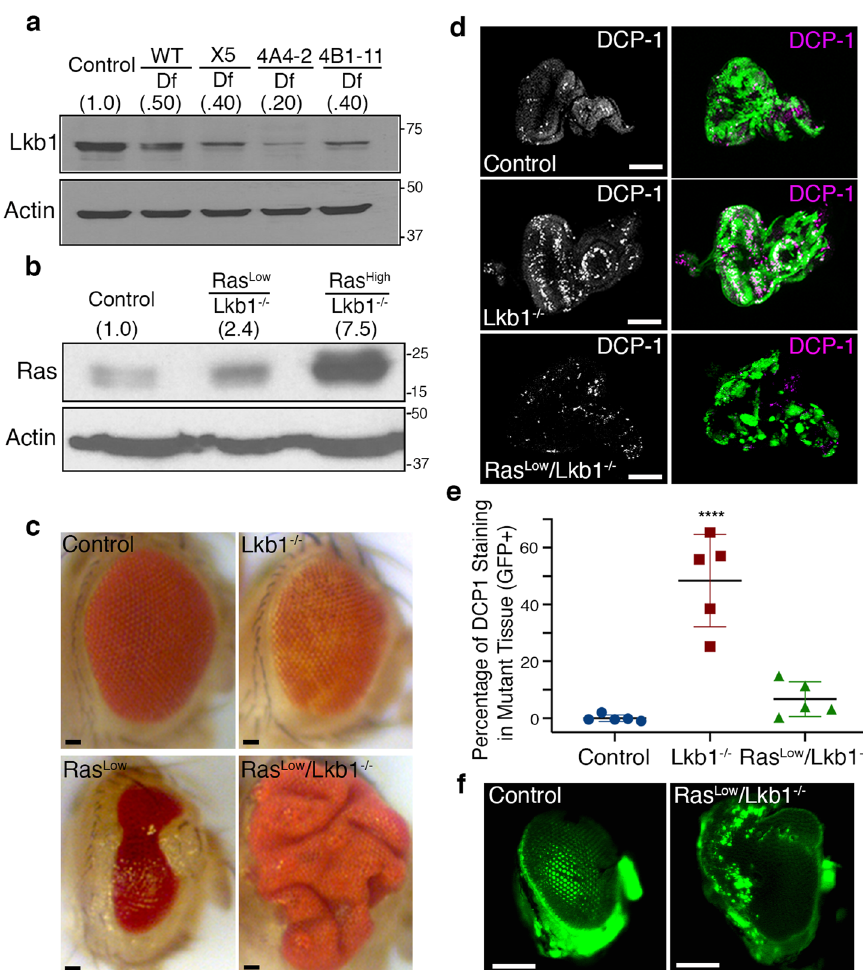
Fig. 1 Clonal loss of Lkb1 in vivo results in autonomous cell death. a Western analysis of Lkb1 protein in larvae transheterozygous for a deletion ( Df(3R) Exel6169 ) that removes the Lkb1 gene, and either a wild-type third chromosome or three loss-of-function alleles of Lkb1 (X5, 4A4-2, 4B1-11). b Western analysis of Ras levels in mosaic eye-imaginal disks from the indicated genotypes (control = FRT82B ). Note the Ras antibody detects both endogenous and oncogenic Ras. c Representative bright fi eld images of mosaic adult eyes with clones of the indicated genotypes. Scale bar, 20 µ m. d Confocal maximum intensity projections of third instar mosaic eye discs carrying GFP-tagged clones of the indicated genotypes, and stained for endogenous death caspase 1 (DCP1, magenta). Scale bar, 100 µ m. e Percentage of DCP1 staining in GFP-positive mutant tissue was quanti fi ed from n = 5 imaginal discs per condition using thresholding in FIJI (ImageJ). Data are represented as mean with error bars representing standard deviation (**** p = 0.000006, one-way ANOVA with multiple comparisons). f Fluorescent images of adult eyes carrying GFP-labeled clones of the indicated genotypes. Images are representative of n = 10 independent fl ies per genotype. Scale bar, 100 µ